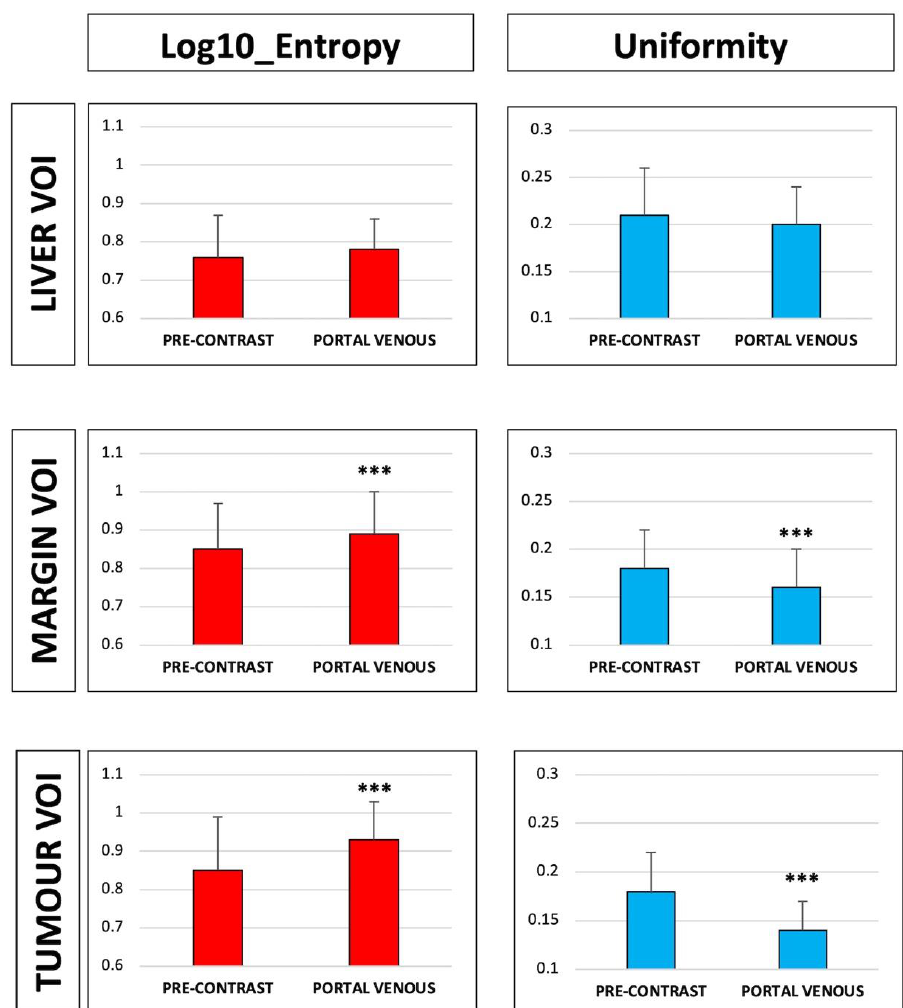
Figure 3. Comparison of entropy and uniformity of Tumor, Margin, and Liver volume of interest (VOI) in the pre-contrast vs. portal phase. *** p < 0.001.